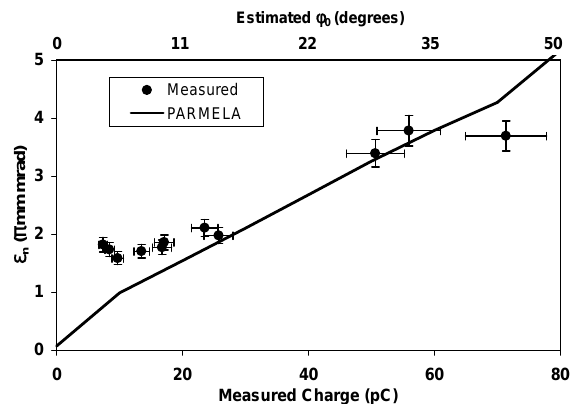
FIG. 11. Dependence of normalized emittance on charge for a 0.8 MeV beam as determined from measurement (dots) and PARMELA simulations (solid line). The incident UV laser energy is about 15 m J. Estimates of the laser injection phase, f 0 , based on field enhancement of the quantum efficiency, are displayed on the upper horizontal axis.